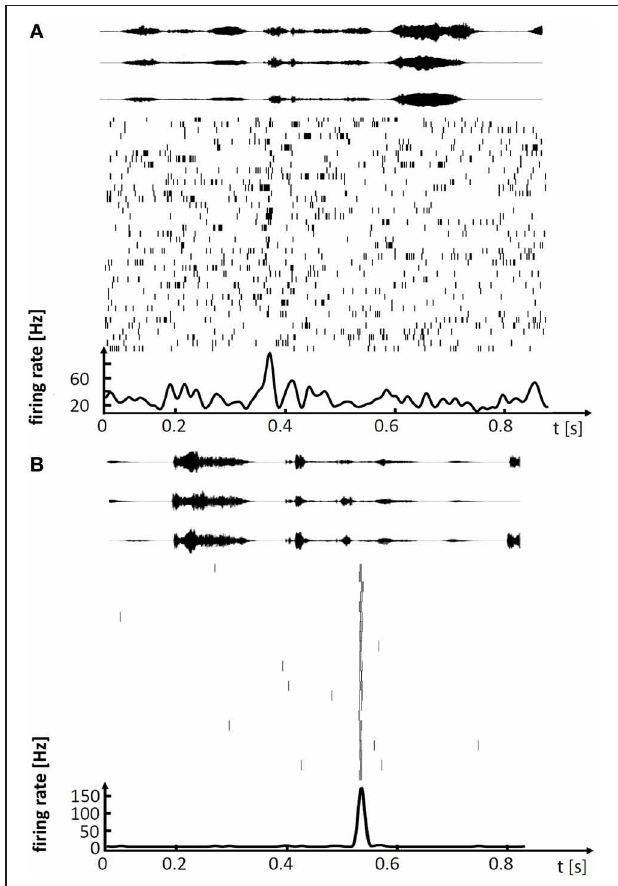
FIGURE 1 | Spiking activity in single neurons of singing zebra finches, illustrating (A) a variable premotor code in LMAN and (B) a stereotyped code in HVC. (A) Spike raster plot of LMAN projection neuron aligned to 41 renditions of the stereotyped song motif. Three exemplary sound oscillograms of the motif are shown on top. The neuron produces single spikes and spike bursts at different times in each rendition of the motif. The motif-averaged firing rate is shown at the bottom. (B) Spike raster plot of HVC projection neuron aligned to 22 renditions of the stereotyped song motif (in a different bird), three exemplary motif oscillograms are shown on top. In each rendition of the motif the neuron produces a brief burst of spikes at precisely the same